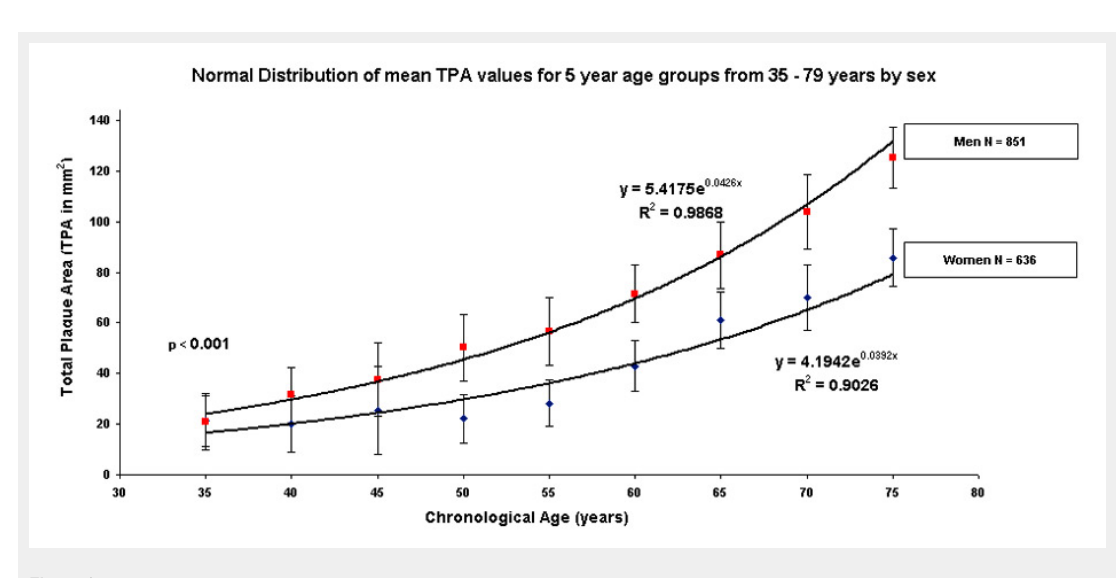
Figure 1 Distribution of mean (± standard deviation) TPA values by age group in 851 men and 636 women. Exponential curve of total plaque area (TPA) for 851 male and 636 female patients aged between 35 and 79 years. The formulae shown above the male curve in red and below the female curve in blue form the basis of the arterial age